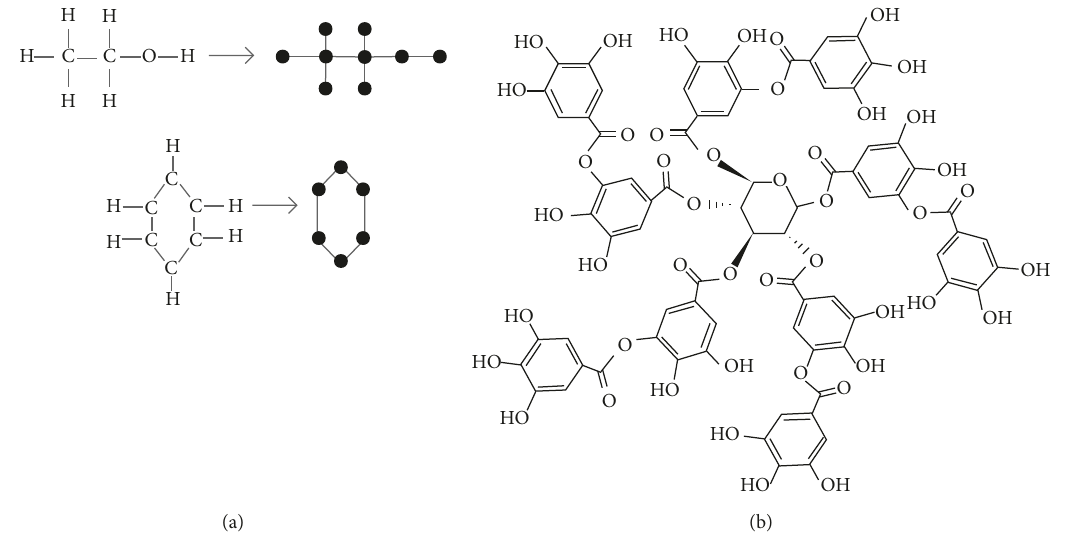
Figure 1: Transformation from molecular structure to molecular graph network. Representation of (a) two small molecular structures and (b) a large molecular